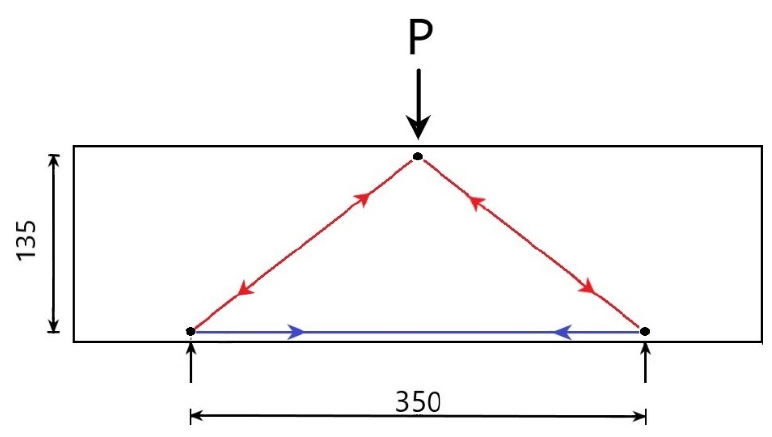
Figure 7. Rods and straps model used for the analysis.